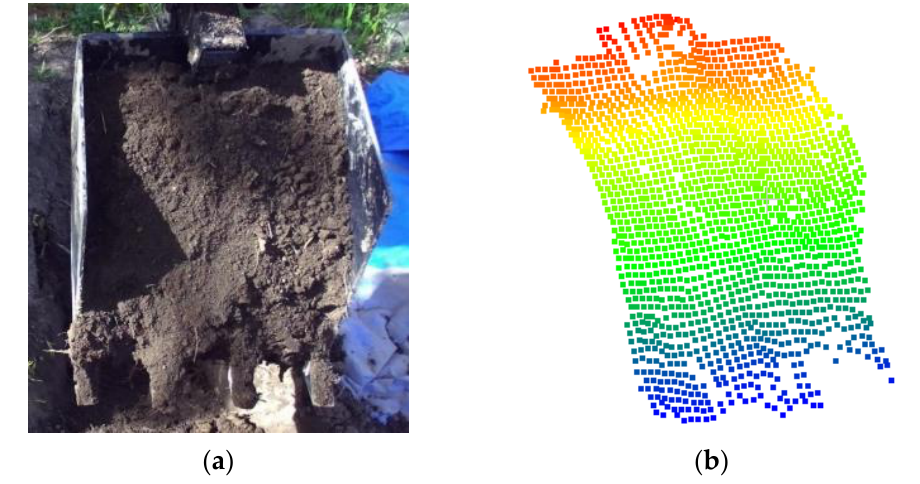
Figure 12. ( a ) Bucket volume image; ( b ) bucket point cloud .